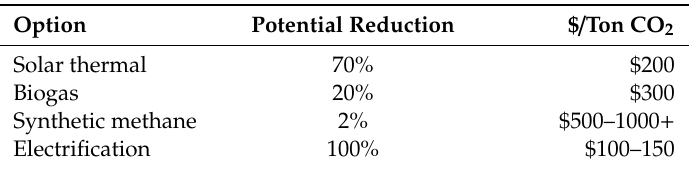
Table 1. Summary of decarbonization